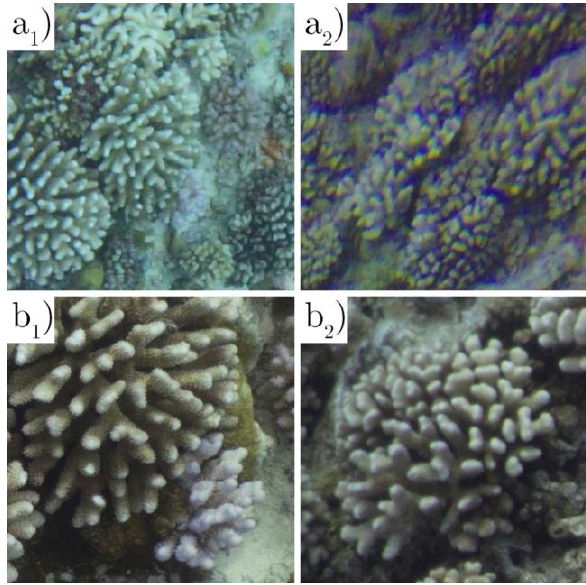
Figure 1. Coral testfield no. 18 (roughly 5 x 5 meter within the control points marked from 1 to 5). The blue rectangle Figure 2. Sections of example images of a) GoPro and b) Lumix highlights the section (roughly 2 x 2 m) were we extracted two GH4 cameras. The left column (subscript 1) shows the image small areas used for comparing the dense point clouds of the quality at the center of the frame and on the right column different correction models. (subscript 2), at the very corner of the